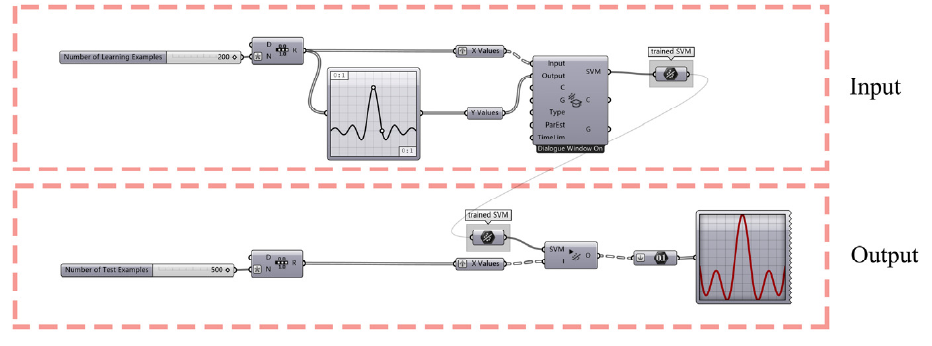
Figure 9. SVM battery pack.